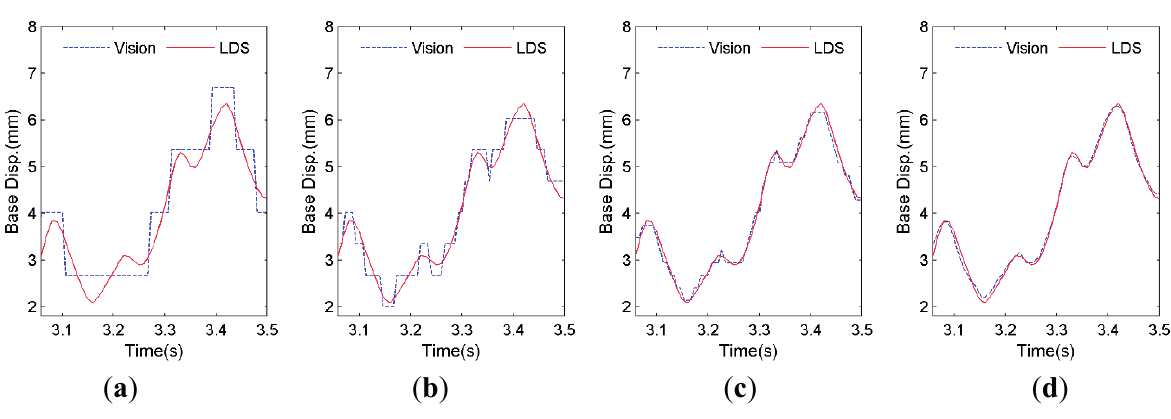
Figure 6. Subpixel resolution evaluation ( a ) Resolution: ±1.338 mm; ( b ) Resolution: ±0.669 mm; ( c ) Resolution: ±0.268 mm; ( d ) Resolution: ±0.067 mm.